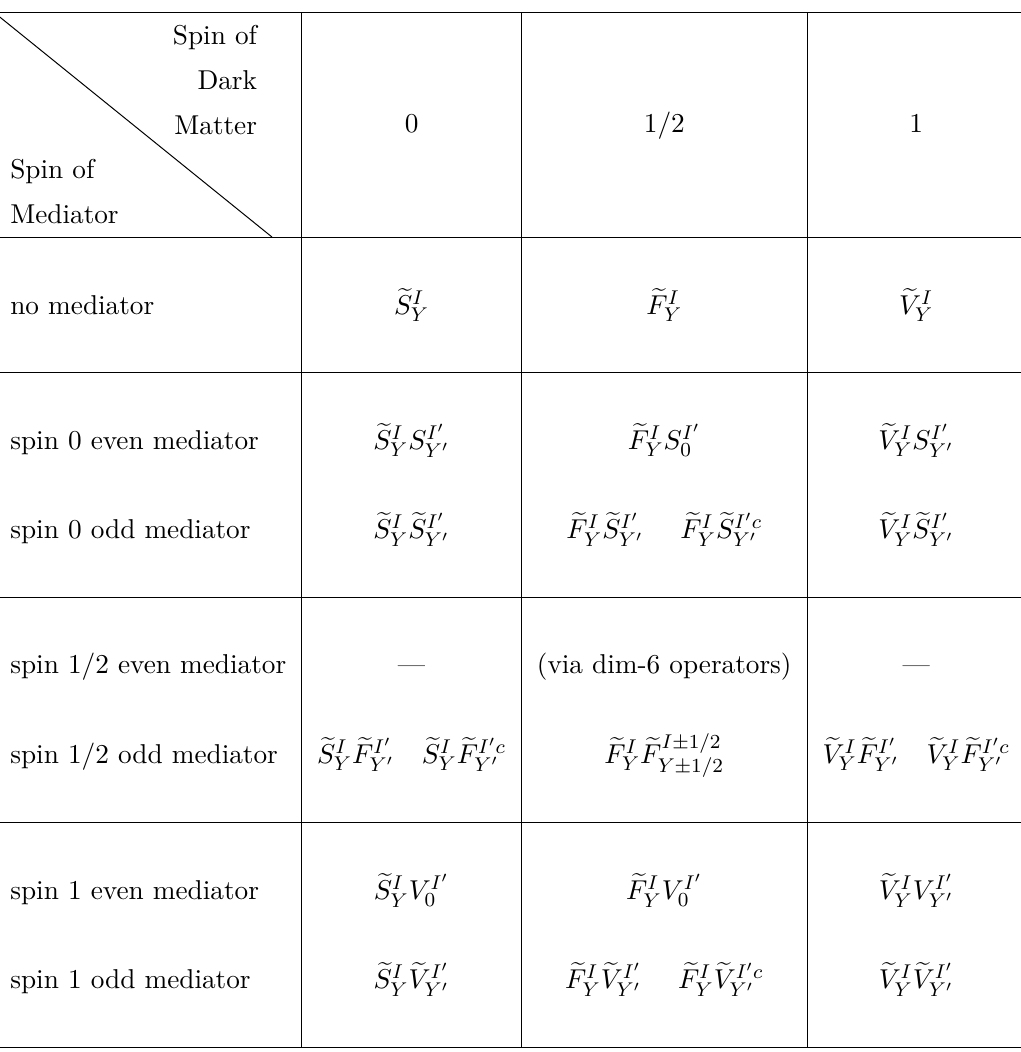
Table 1. Classification of MCDM models in Spin(DM)-Spin(mediator) space. When possible, the Dirac fermion can be replaced by a Majorana one, F → M